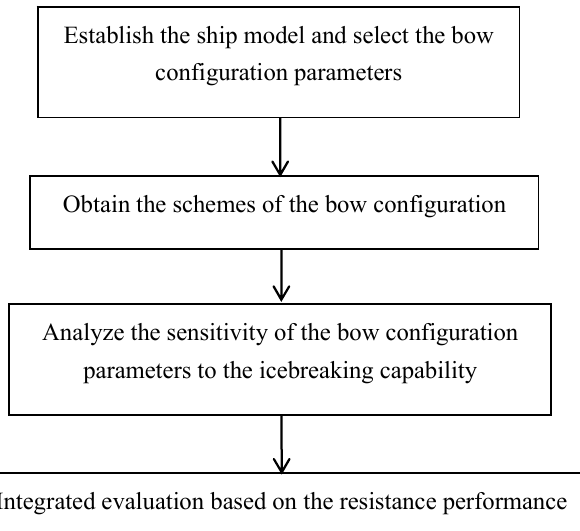
Figure 6. General workflow for the approach to determine the optimal bow configuration.